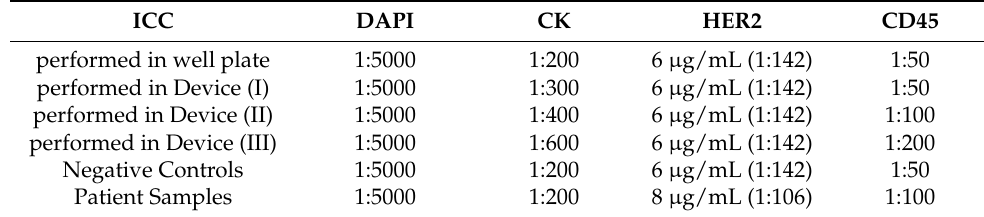
Table 4. Working dilutions tested for each of the selected antibodies in the ICCs performed. ICC DAPI CK performed in well